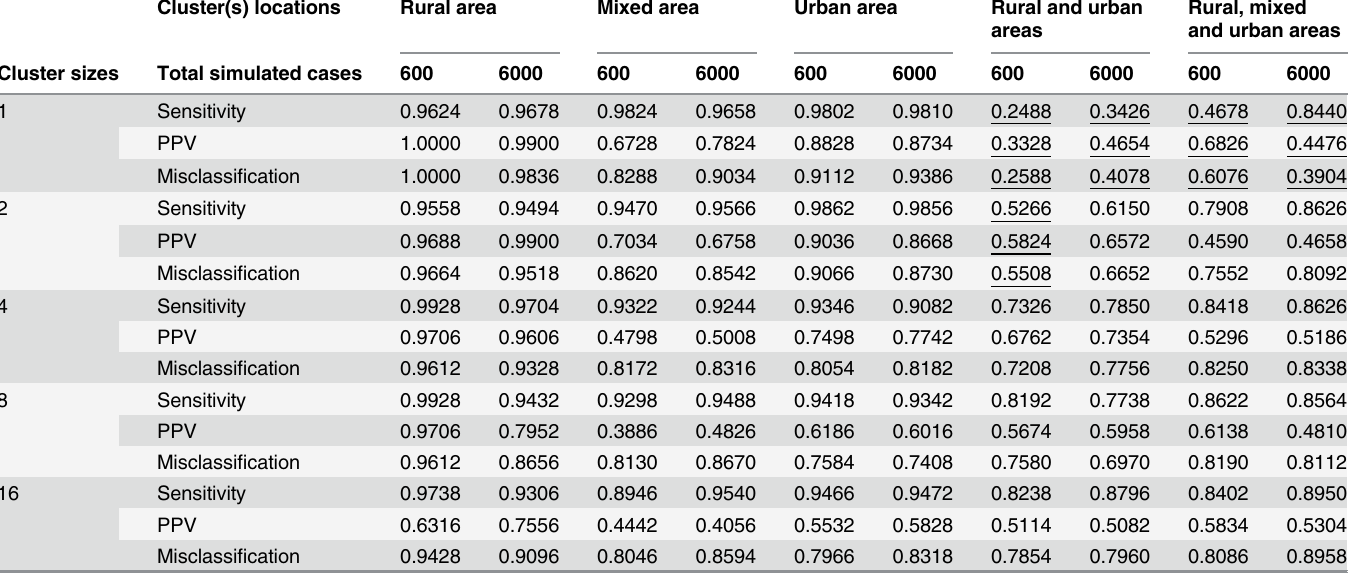
Table 2. Agreements of MCS-P with the other performance measures in different scenarios. Cluster(s)